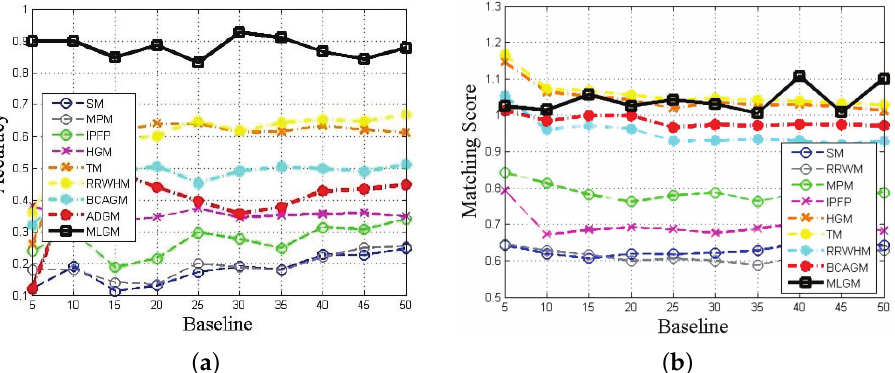
Figure 13. Trend chart of matching accuracy and score of the Duck dataset. ( a ) Accuracy of the Duck dataset. ( b ) Matching score of the Duck